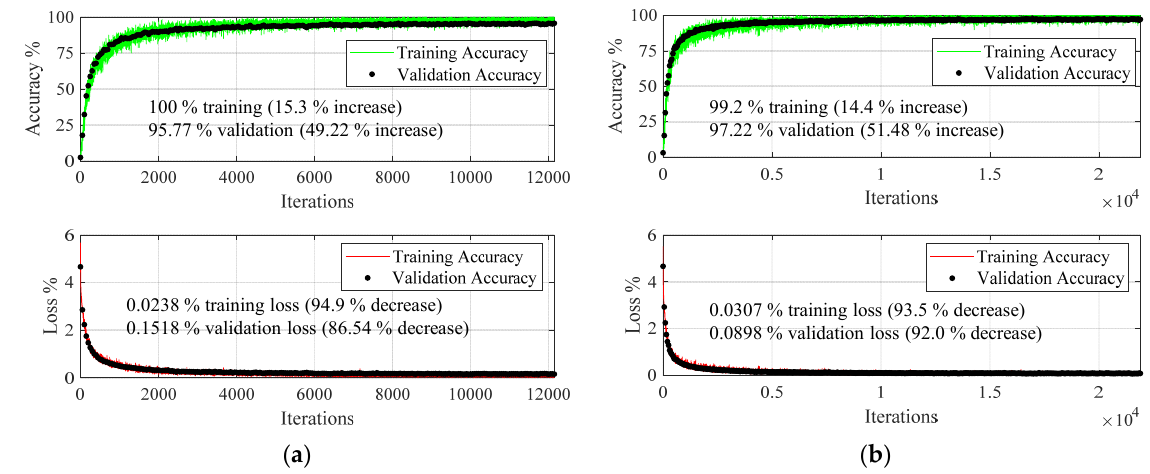
Figure 19. Training and validation results on augmented data via customized deep learning model: ( a ) results on data augmented through eight virtual sensors; ( b ) results on data augmented through 16 virtual sensors. (Solid line shows training, dot refers to validation).